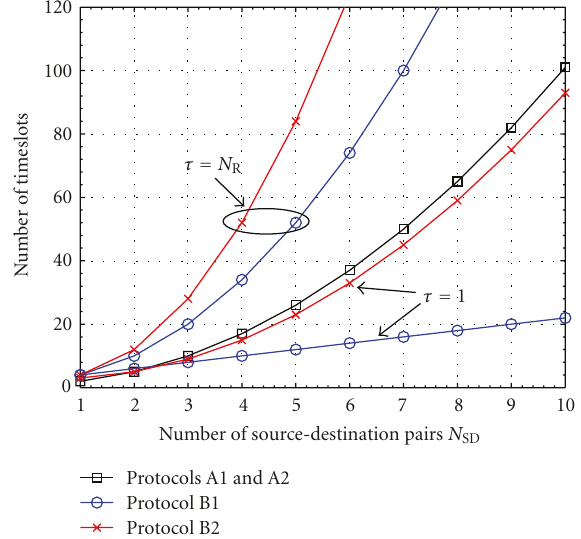
Figure 3: Number of timeslots required to estimate all channel coe ffi cients and perform phase synchronization (for protocols B1 and B2) for the case that N R = N 2